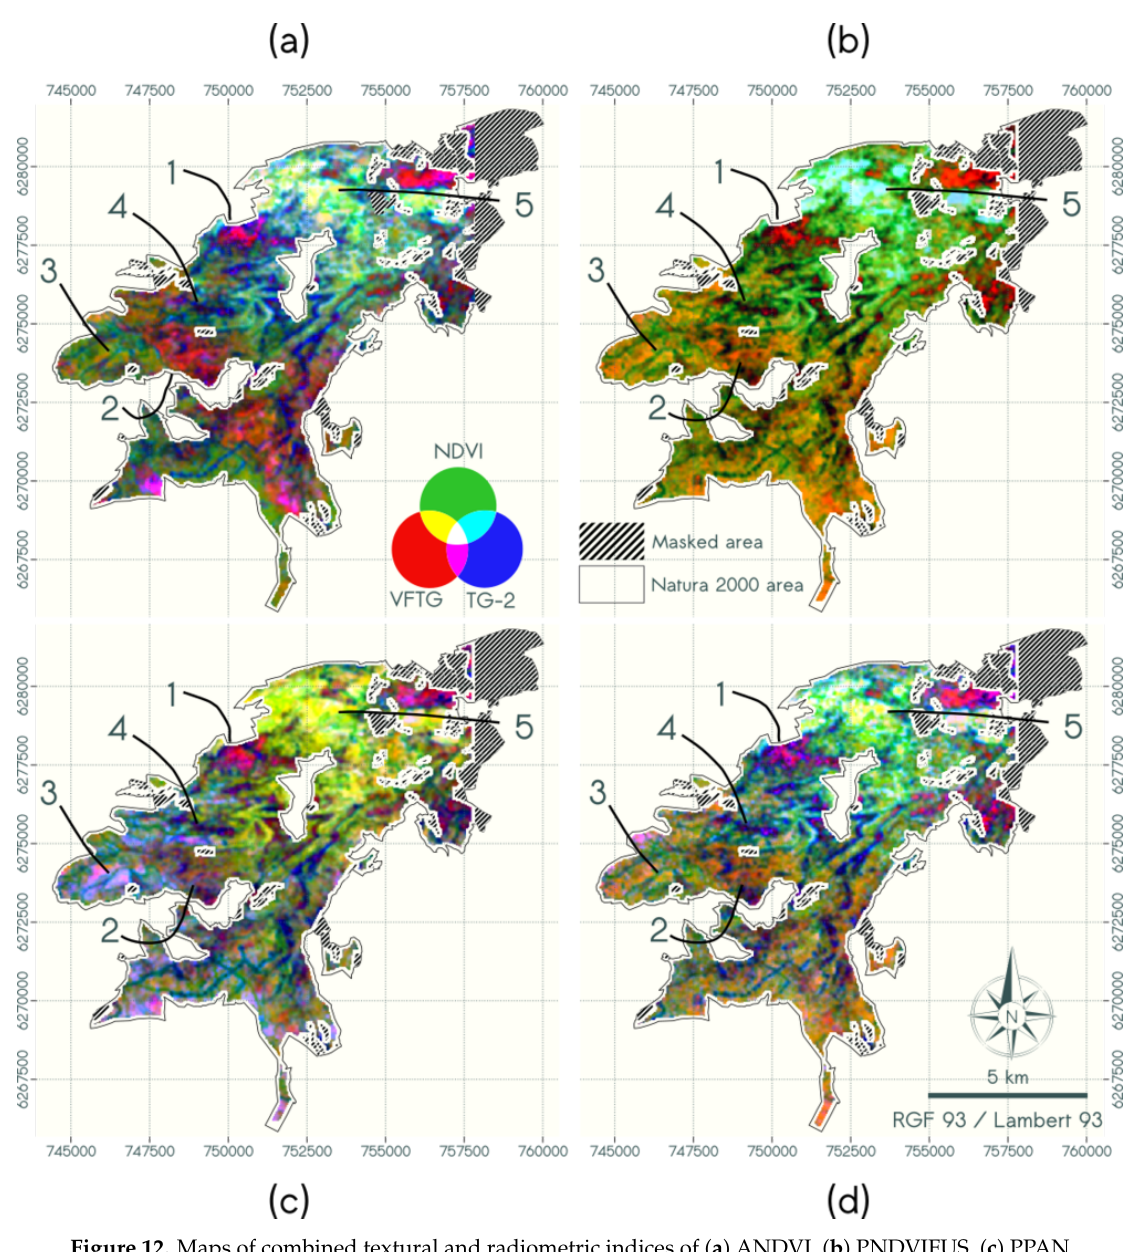
Figure 12. Maps of combined textural and radiometric indices of ( a ) ANDVI, ( b ) PNDVIFUS, ( c ) PPAN and ( d ) PNDVI using a RGB color composition (with R = VFTG, G = mean NDVI, B = TG-2). Main vegetation structure types are located on the maps by arrows with two structure types of highly mix of herbs and low ligneous with (1) early stage of encroachment of herbs by low ligneous ( Quercus coccifera ); (2) herbs and low ligneous ( Juniperus oxycedrus ); (3) dense cover of low ligneous ( Quercus coccifera ); (4) dry grassland and (5)